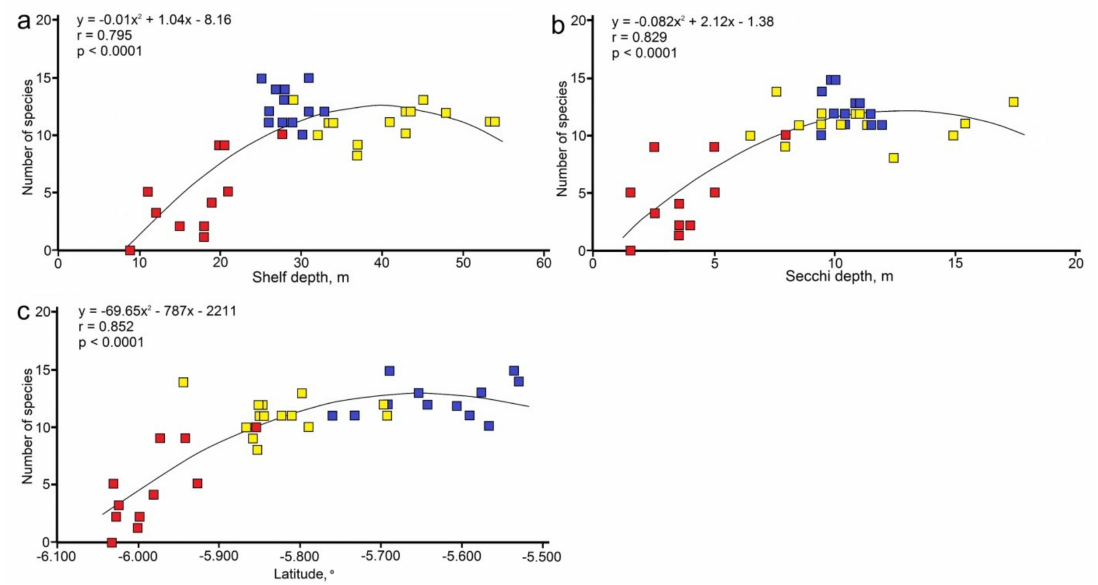
Figure 7. Significant relations between mushroom coral diversity and abiotic parameters off Jakarta for shallow reef depths (2–6 m): ( a ) shelf depth; ( b ) secchi depth; ( c ) latitude. At some offshore localities, such as Pulau Putri in Zone 3, reefs were damaged at shallow depths because of blast fishing. Living mushroom corals were found in between dead and live coral fragments of other species (Figure 8).